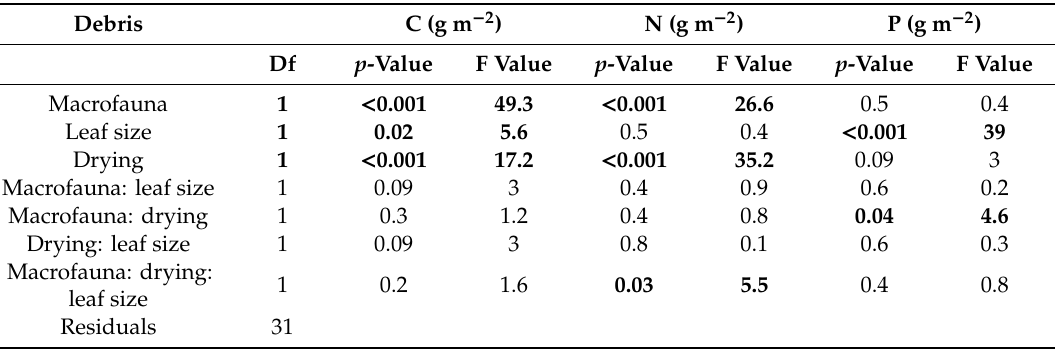
Table 5. Results of three-way ANOVA testing the e ff ects of the three factors macrofauna, leaf size and drying on the C, N and P content in the debris recovered from each microcosm at the end of the experimental period. Significant values are printed in